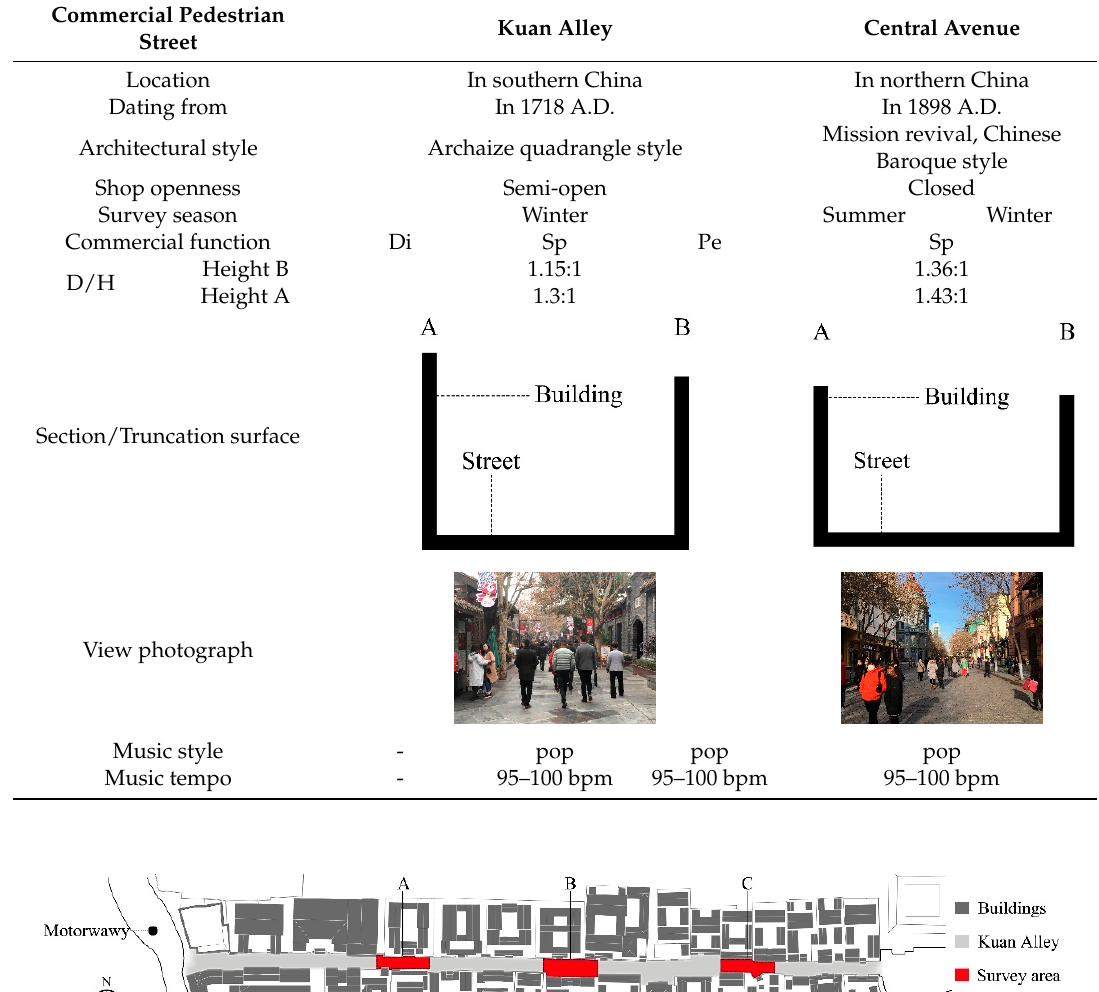
Table 1. The fundamental state of the survey sites.